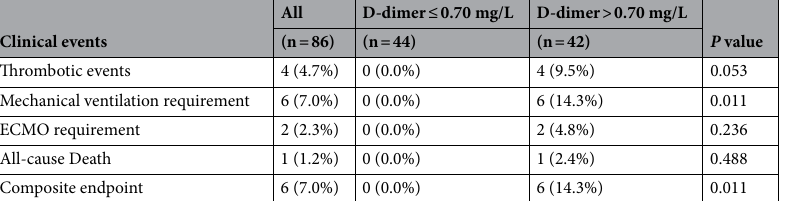
(Table 2). The D-dimer levels were significantly different across CT score tertiles (0.37 mg/l [IQR 0.31–0.87], 0.66 mg/l [IQR 0.39–1.43], 1.83 mg/l [IQR 0.85–4.41], for tertile 1–3, respectively; P < 0.001) (Fig. 1A). The natu- ral logarithm of the D-dimer level was significantly associated with the CT score (r S = 0.586, P < 0.001) (Fig. 1B). Comparison of clinical events between patients with D‑dimer ≤ 0.7 mg/L and > 0.7 mg/L.